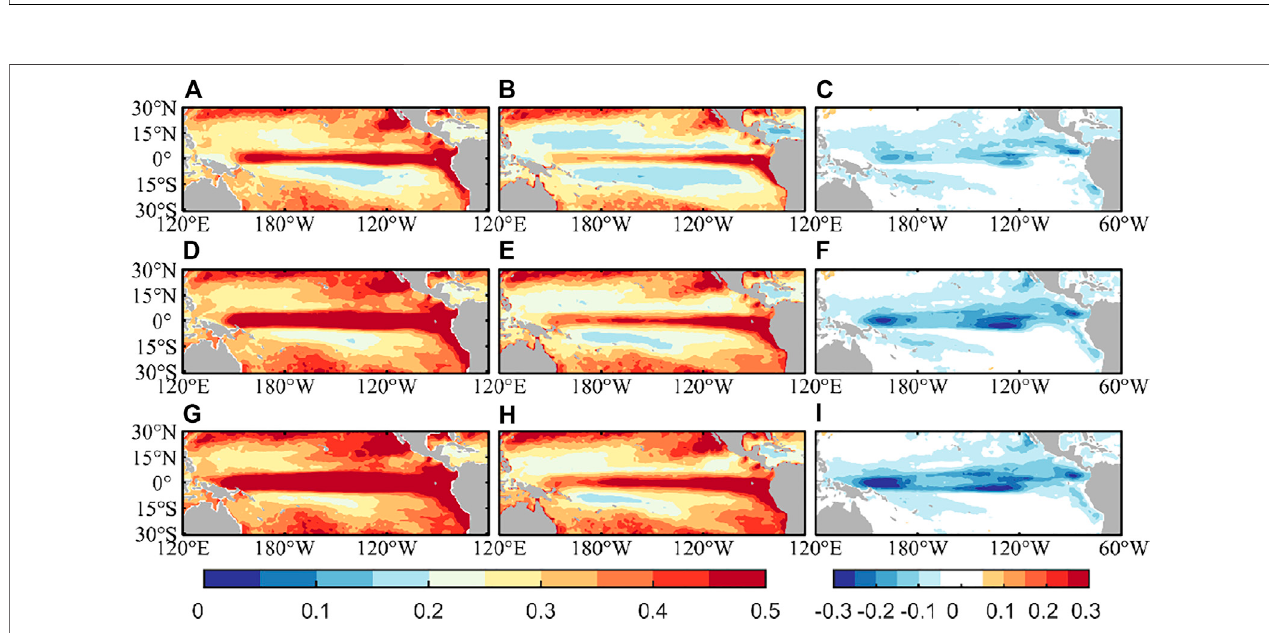
FIGURE6| SpatialdistributionoftheSSTAACCinthetropicalPaci fi cfordifferentleadmonths, (A,D,G) FIO-CPSv1.0results, (B,E,H) FIO-CPSv2.0results,and (C, F, I) the difference between FIO-CPS v2.0 and FIO-CPS v1.0. The result for (A – C) 2-month lead time, (D – F) 4-month lead time, and (G – I) 6-month lead time.